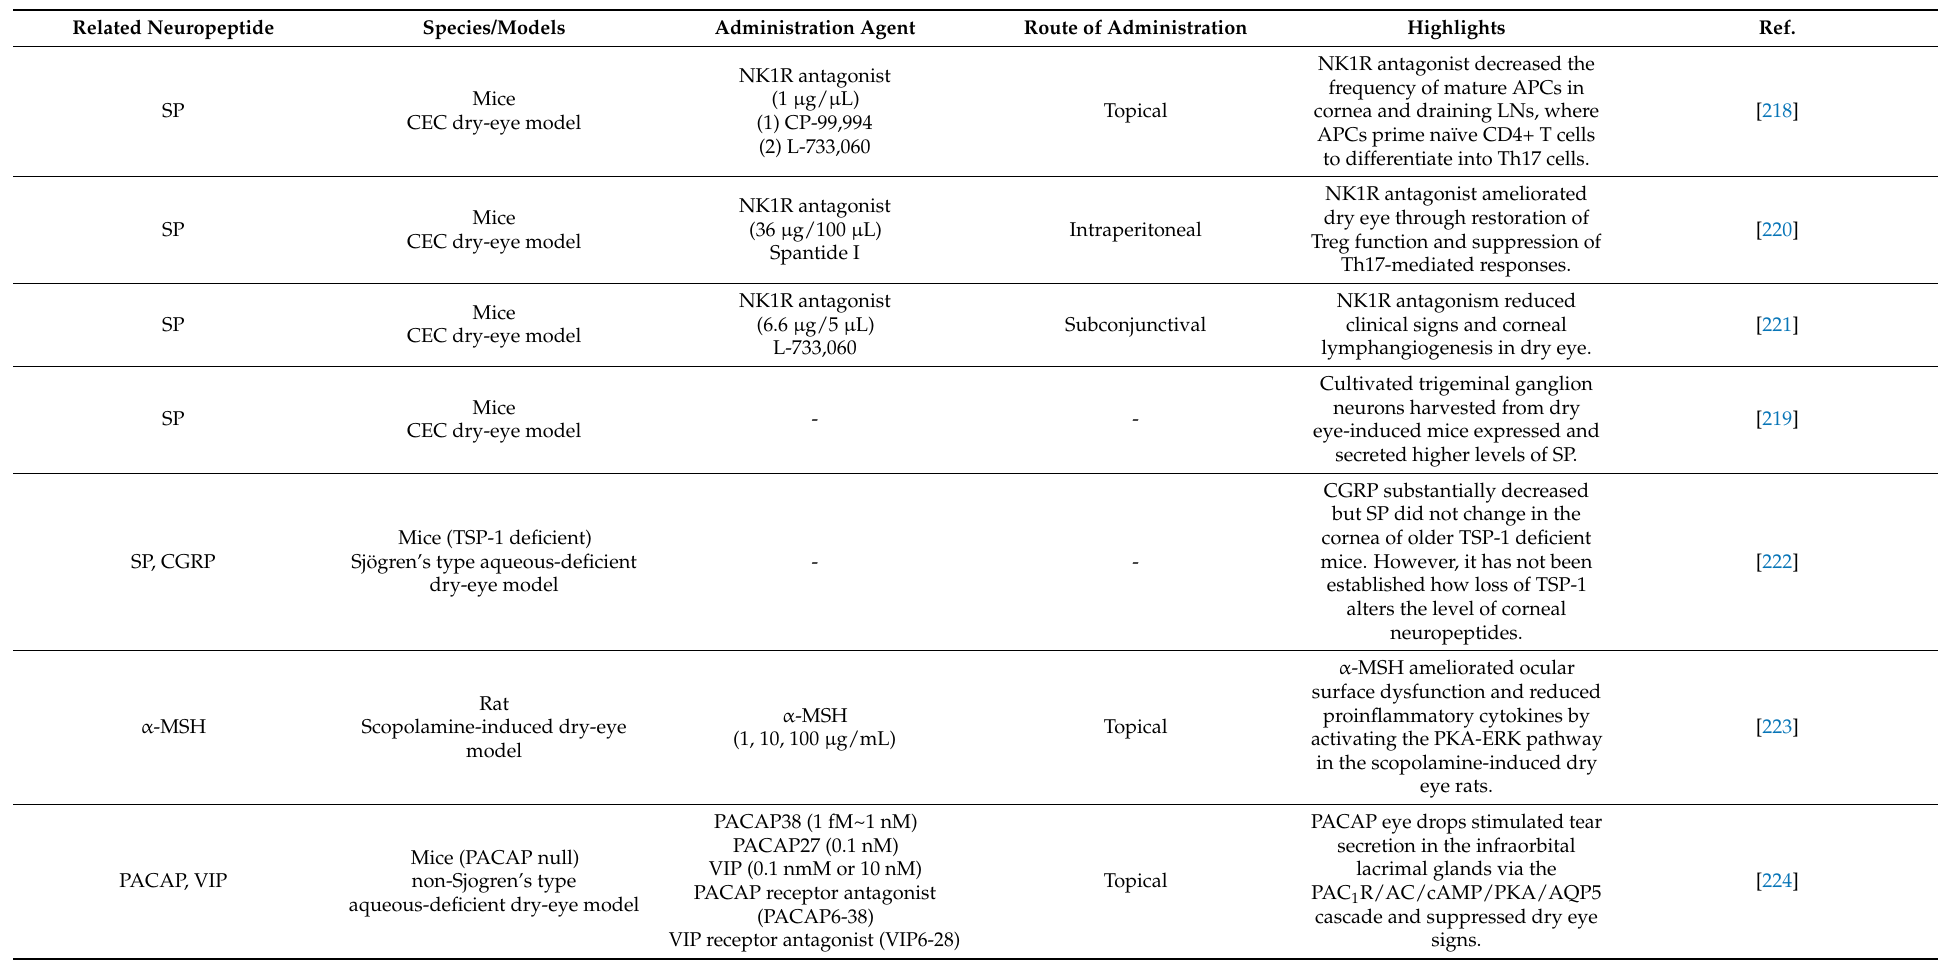
Table 3. Preclinical studies to elucidate the role of neuropeptides/neuropeptides specific receptors in the pathogenesis of dry eye disease. Related